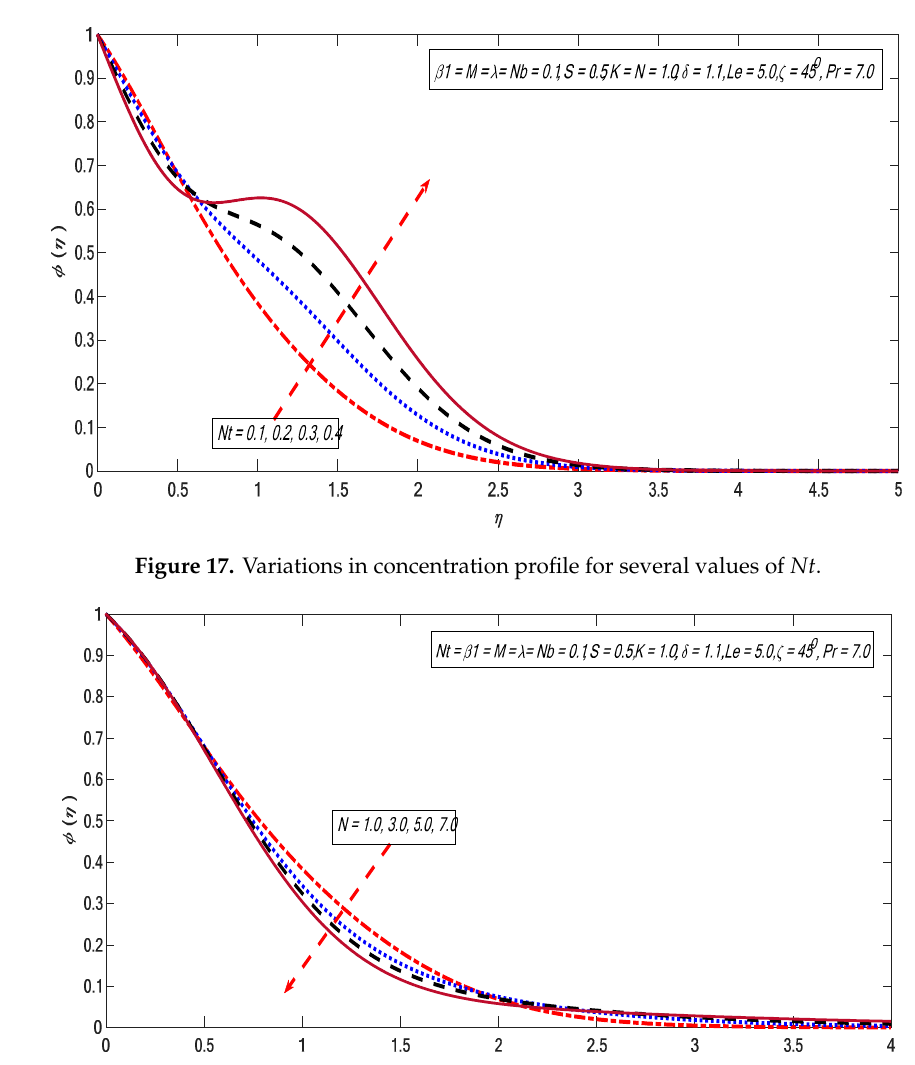
Figure 16. Variations in concentration profile for several values of 𝑁𝑏 .